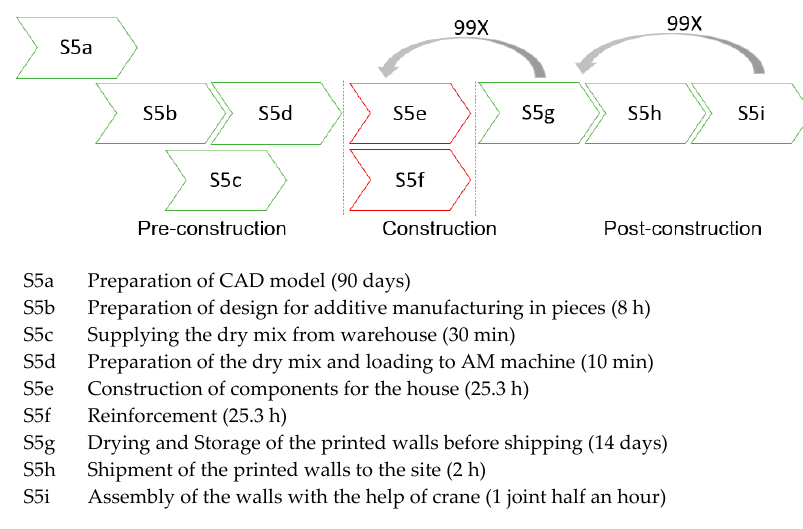
Figure 7. The process map for Scenario 5.